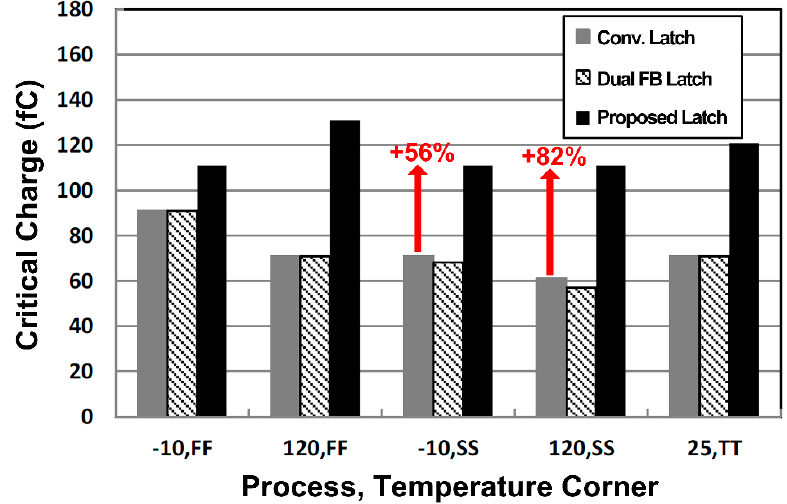
Figure 8. Critical charge ( Q crit ) comparison at the process and temperature corners with conventional latch (Figure 4), dual feedback latch (Figure 5), and proposed delay-based dual feedback latch (Figure 6).